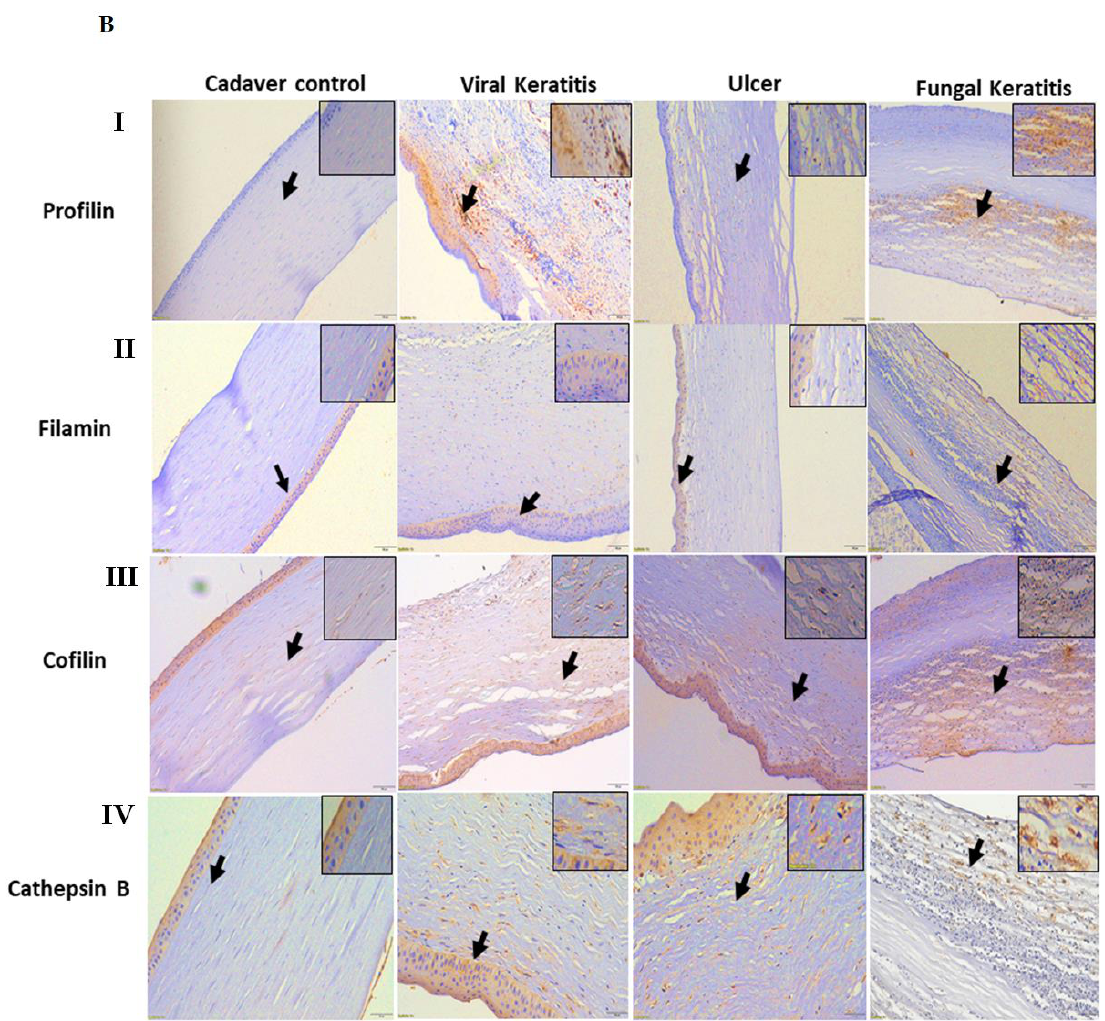
Figure 5. ( A ) (i) Western blotting: Ten micrograms of total cellular proteins from various cell lines were electrophoresed through a denaturing polyacrylamide gel, electroblotted and hybridized with actin cytoskeletal proteins cofilin (COF), profilin 1 (PROF1) and annexin A2 (ANXA2) in kerato- cytes, fibroblasts and myofibroblasts as normalized to glyceraldehyde-3-phosphate dehydrogenase (GAPDH). (ii–iv) Densitometry analysis of proteins: Quantification levels of cofilin, profilin 1 and annexin A2 in KCT, HCF and MYO cell lines. All proteins have been analyzed on the same gel. ( B ) (I–IV) Immunohistochemical analysis of profilin 1, cofilin, filamin A and cathepsin B. Data are from a representative experiment including the fibrotic and non-fibrotic areas of patient cornea and a control cornea. (I) Profilin 1 was predominantly expressed in stroma of viral keratitis and fungal keratitis group and to some extent in stroma of ulcer group. Higher profilin 1 expression in the fibrotic stroma is the representative myofibroblastic activation of stromal fibrocytes as shown in the top lane. Control group did not show any expression of profilin 1. (II). Filamin A expression was significantly higher in stroma of fungal keratitis group as compared to the control. Higher expression of filamin A in stromal scarred tissue indicates the presence of myofibroblast-mediated stromal fibro- sis. (III) Cofilin showed higher expression in fibrotic stroma of all groups (viral keratitis, ulcer and fungal keratitis) as compared to the control. Higher expression of cofilin indicates presence of mature myofibroblasts in the scarred corneal stroma. (IV). Cathepsin B expression was significantly higher in stroma of fungal keratitis, viral keratitis and ulcer as compared to the control. Higher cathepsin B expression indicates myofibroblastic activation of stromal fibrocytes. The arrow represents the scarred area in the tissue as shown by positive